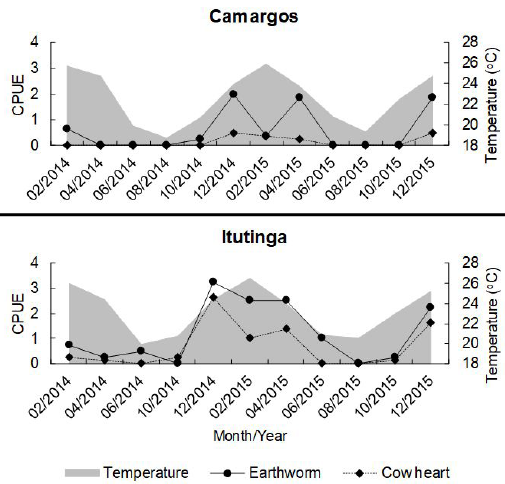
Figure 1. Seasonal variation of water temperature and catch per unit effort (CPUE) of mandi ( Pimelodus maculatus ) sampled by bait type in the tailrace of the Camargos and Itutinga hydropower